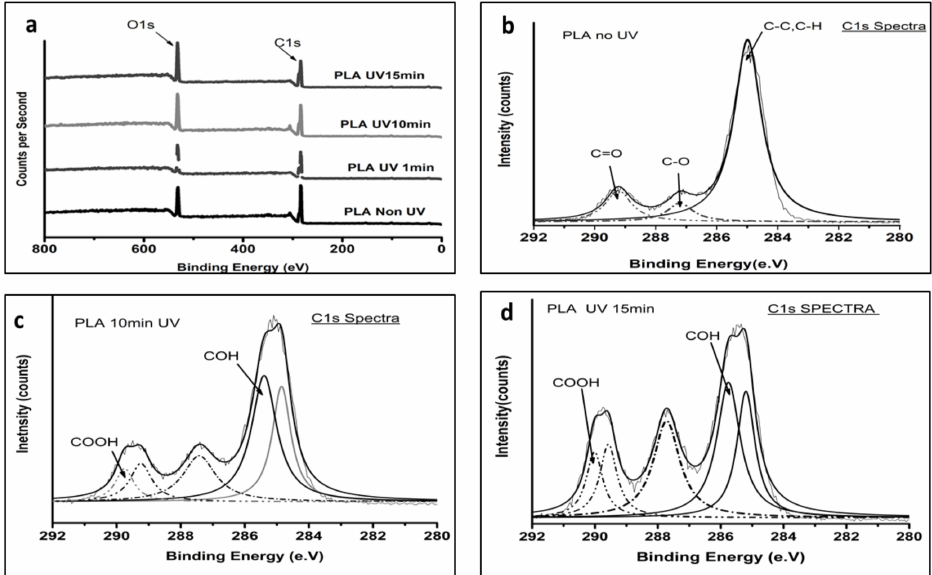
Figure 4. ( a ) Low-resolution XPS scan of UV-irradiated PLA for different time durations. ( b – d ) C1s XPS detailed spectrum of non-UV irradiated PLA compared to 10- and 15-min UV irradiated PLA, respectively.